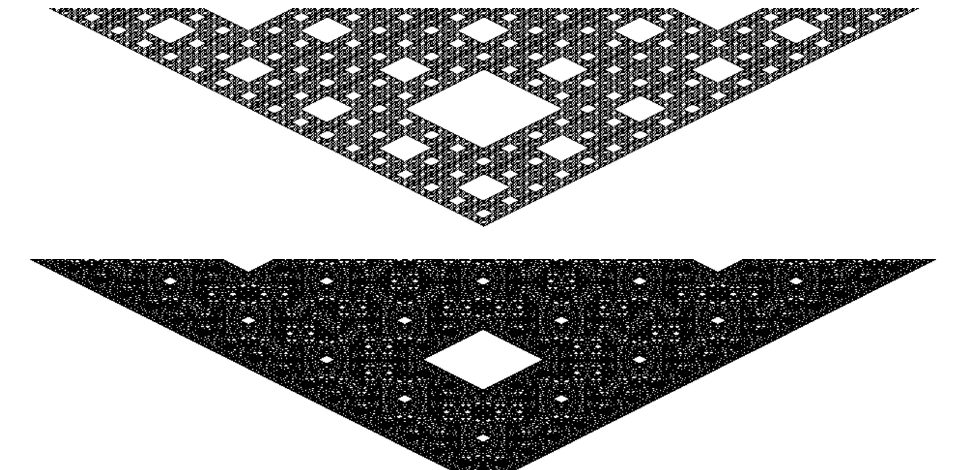
Figure 16 . In the top figure, we show the time-evolution of an initial operator from I which is non-trivial on one site in the perfect tensor model. In the bottom figure, we show the time-evolution of an operator non-trivial on 40 sites. Time increases in the upward direction, and the time-evolved operator has non-trivial support on black sites, and the identity operator on white sites. It is evident from the examples that for fixed time, fewer voids are formed in the case where the initial operator is